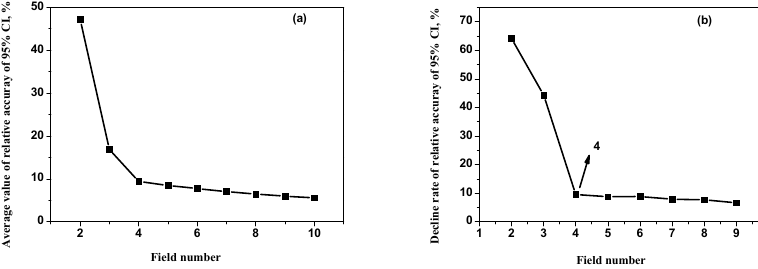
Figure 11. The variation curves of the average relative accuracy of 95% confidence interval ( a ) and its decline rate ( b ) with different fields for TRIP780 steel.